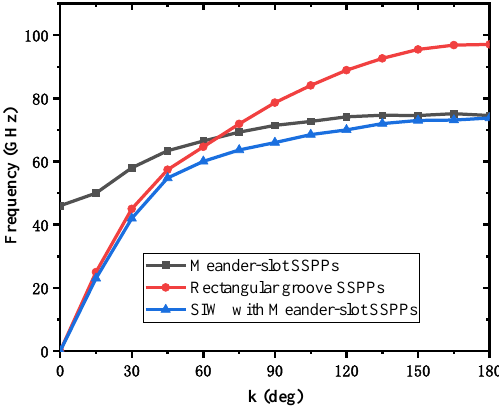
Figure 4. Dispersion curve of the unit cell.